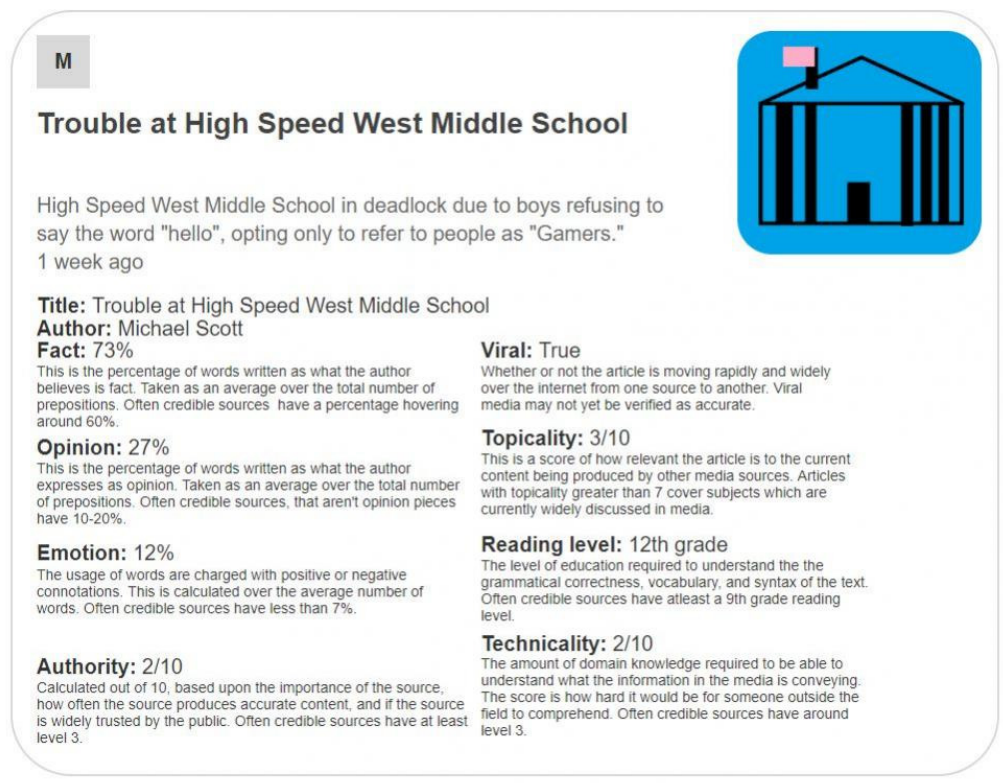
Figure 5. Informational label with article summary and component score descriptions [76].